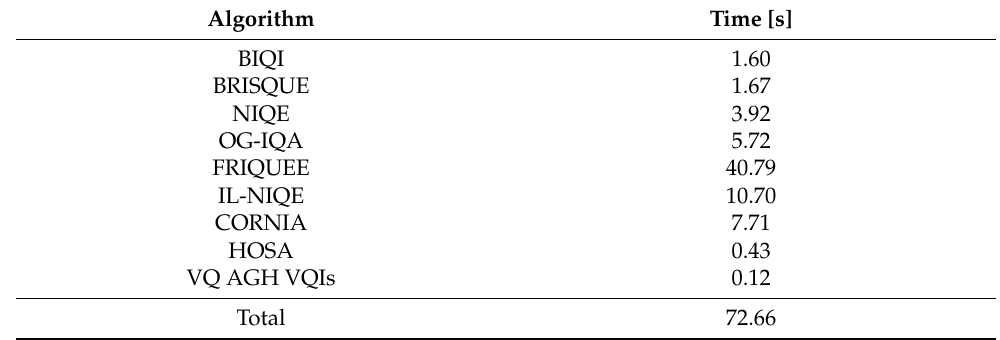
Table 4. Execution time of each working Video Quality Indicator (VQI). The execution time for VQ AGH VQIs is a combined execution time of each individual VQI and comes from